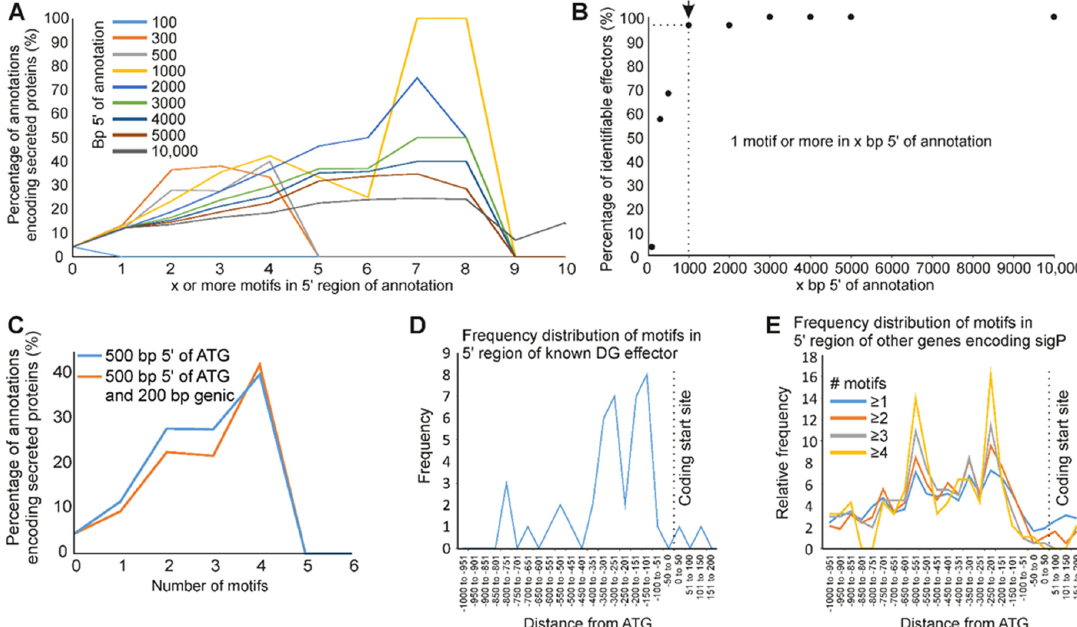
Figure 5. Location of a promoter motif associated with dorsal gland effector genes in M. incognita . ( A ) For promoters that contain x or more copies of the motif (where x varies from 0 to 10), the proportion of annotations that encode putatively secreted proteins is shown. Colors represent repeats of the analysis with different promoter lengths (ranging from 100 bp to